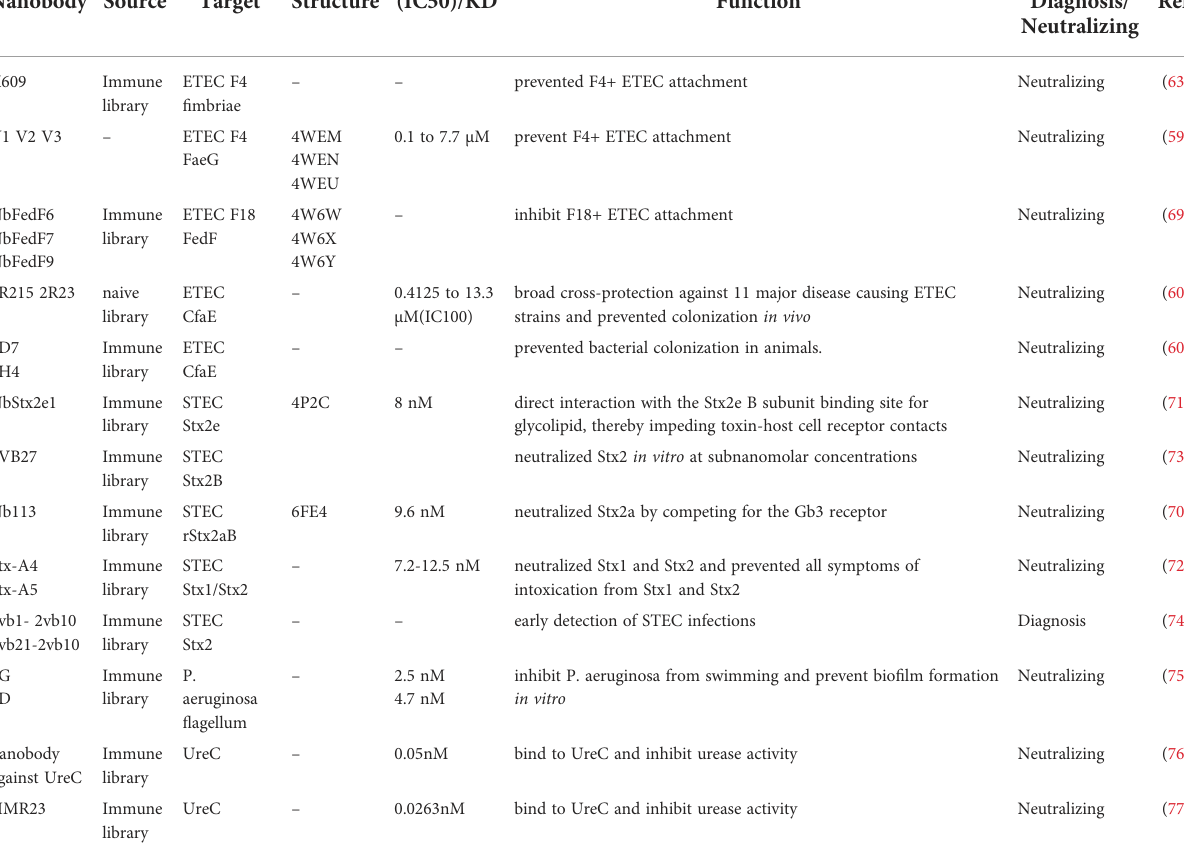
TABLE 2 SdAb reports to diagnose and/or neutralizing infections by Gram-negative